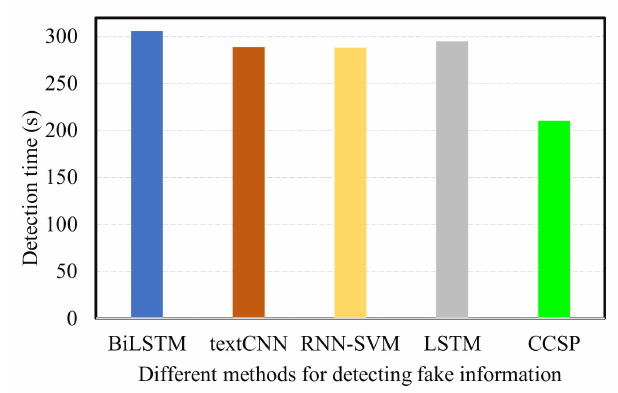
Figure 3. Fake information detection time.